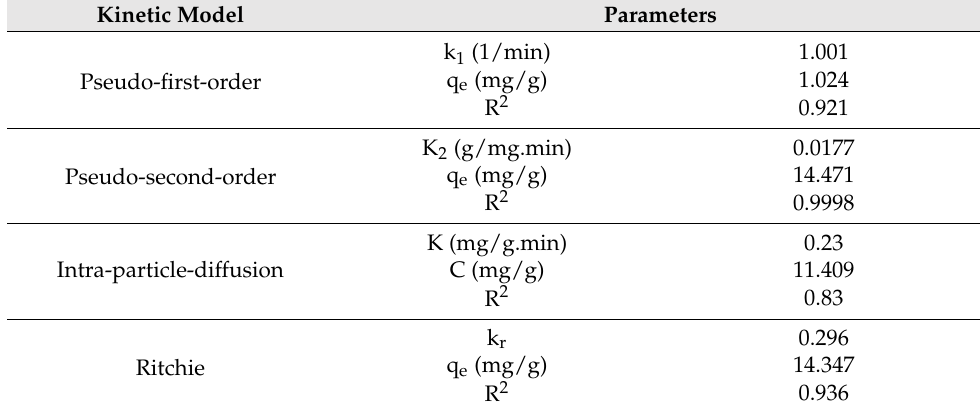
Table 3. Kinetic parameters of fitting to various isotherm